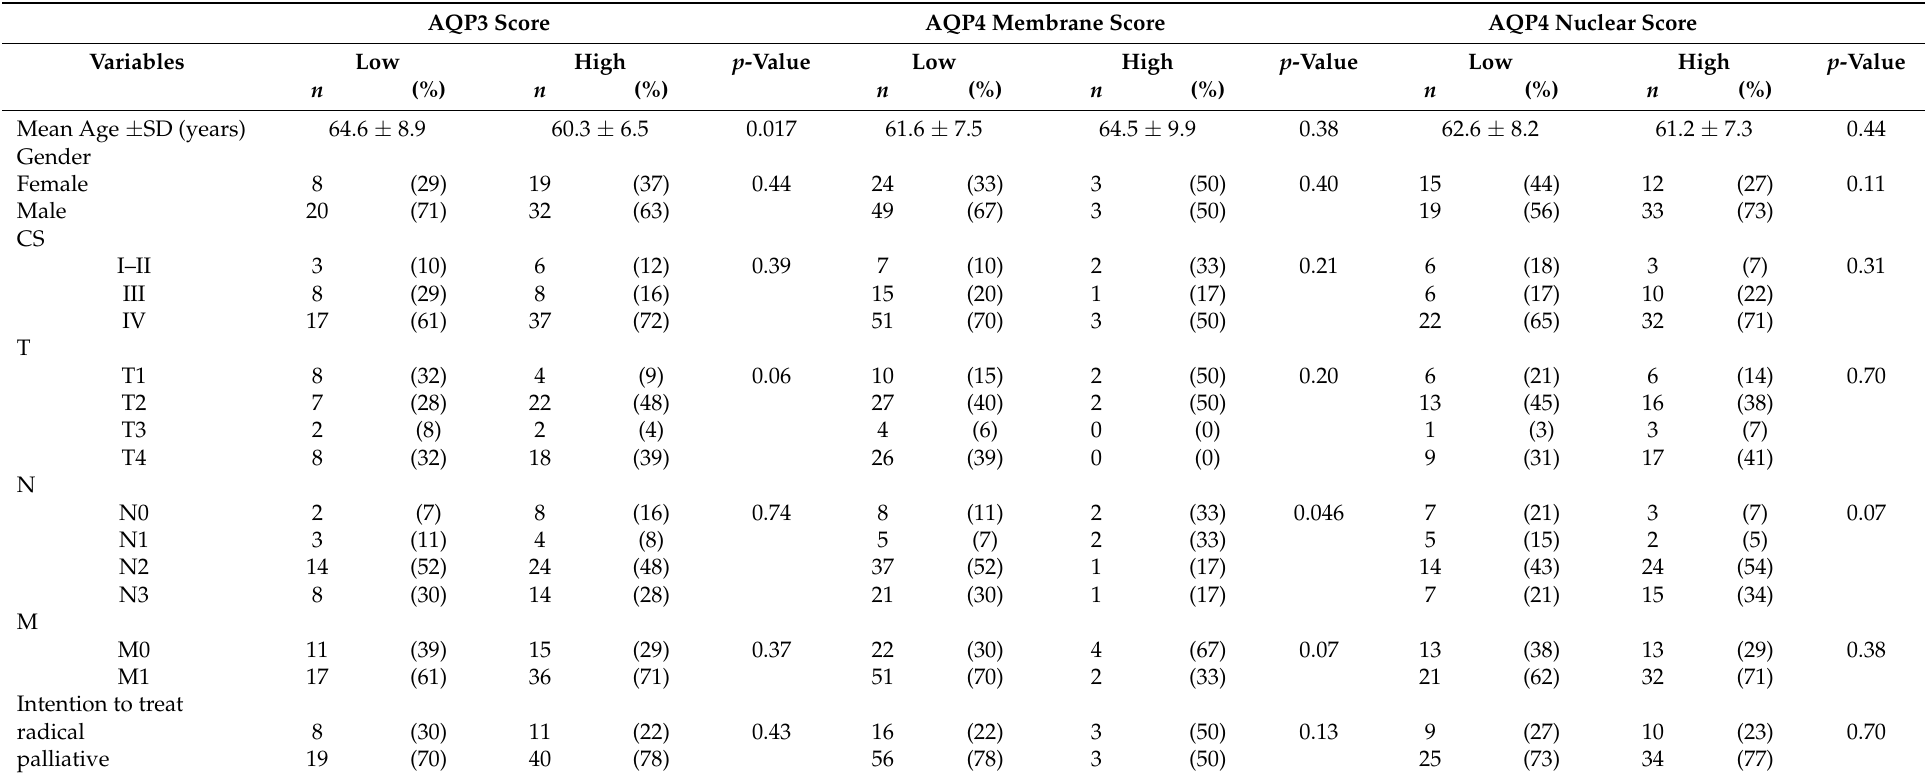
Table 2. Relationship between aquaporin 3 (AQP3) and aquaporin 4 (AQP4) and clinical-/pathological features of patients diagnosed with lung adenocarcinoma (ADC) in this study. AQP4 Membrane